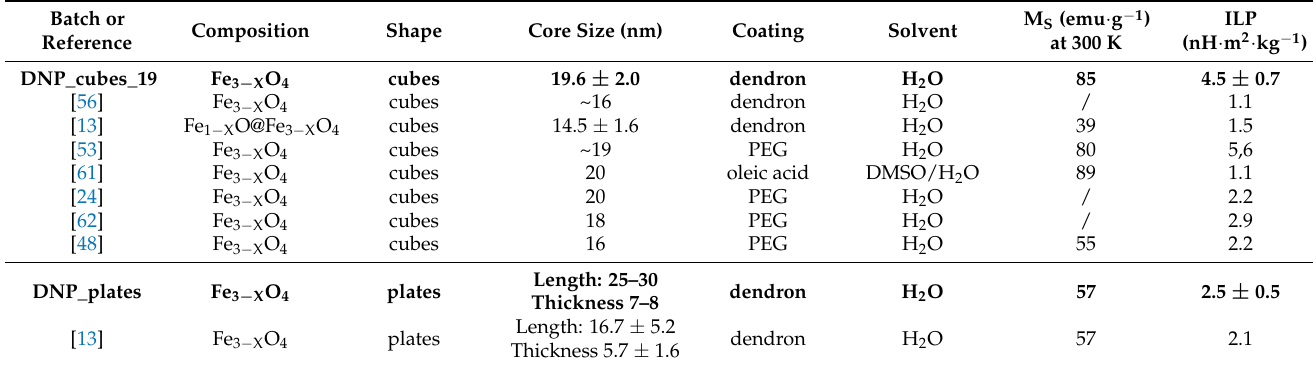
Table 6. Comparison of ILP values of DNP_cubes_19 and DNP_plates with reported values for similar shaped IONPs.